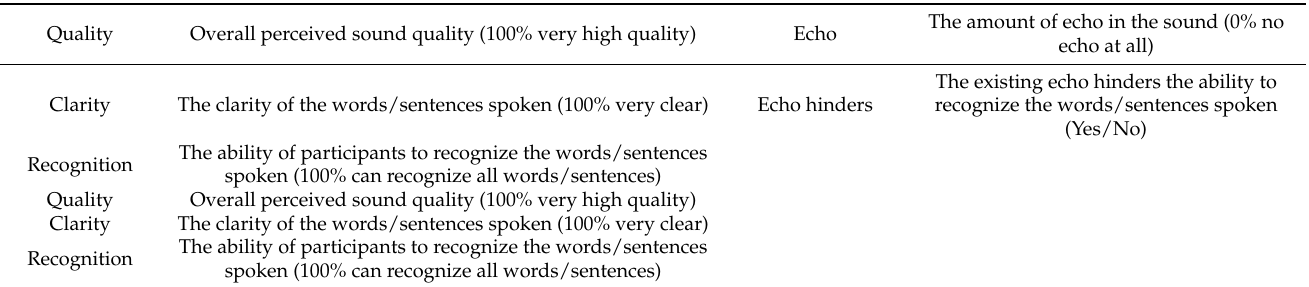
Table A1. Description of Survey